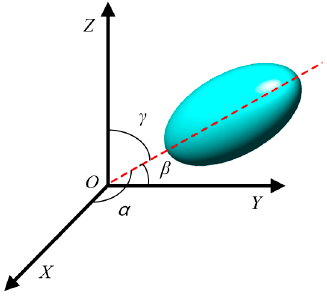
Figure 13. Orientation of ellipsoidal aggregate.